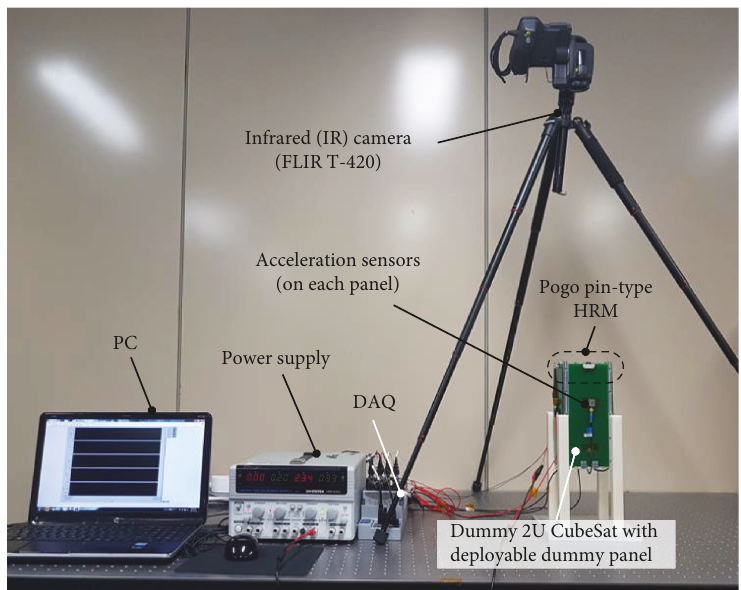
Figure 6: Test setup for a release function test of the demonstration model of the pogo pin-type holding and release mechanism.